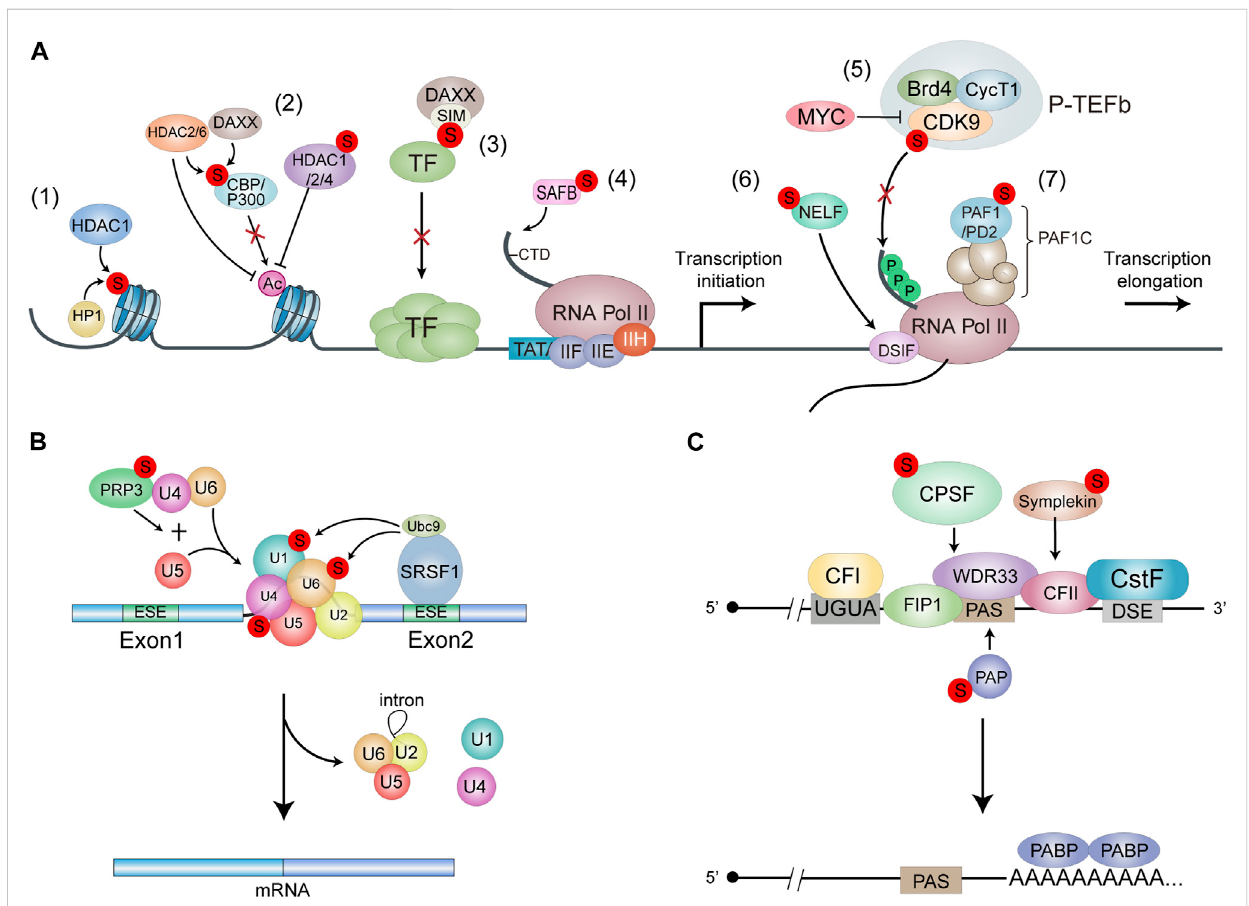
FIGURE 2 Models for the functions of SUMOylation in RNA transcription and processing. (A) SUMOylation leads to transcnptional repression. Histone SUMOylation mediates transcriptional repression through recruitment of HDAC1 and HP1 (1). SUMOylation of p300 and CBP recruits HDAC6 and DAXX/ HDAC2 respechvehi, leading to SUMO-dependent transcnptional repression. SUMOylation of liADC1/2/4 promotes the deacetylase activity to repress transcription (2). The SIM domain of DAXX provides a molecular explanation for the interaction between DAXX and SUMO-mod-i fi ed transcription factors, resultingIntranscriptionalrepression(3) SUMOylation ofSAFEenhancesitsbinding withRNAPII, therebypromotinggenetransoiption(4). SUMO and MYC antagonistically control global gene expression through regulating COK9 SUMOylation. P-TEFb formation and tran-scriptional elongation. SUMOylation of CDK9 blocks its interaction with Cyclin Ti. Thereby inhibiting the formation of active P-TEFb complex (5). NELF and OSIF bind to the potymerase in a manner that restricts Pol II mobility and impairs further RNA elongation. SUMOylation regulates the recruitment of NELF to promoters upon stress to drive transcriptional downregulabon (6). SUMOytabon of PAF1/PD2 facilitates its interaction with PML proteins (7). (B) SRSF1. Bound to the exonic splicing enhancer (ESE). Interacts with Ubc9 to regulate the SUMOylation of spliceosome protein components. Thuieby increasing